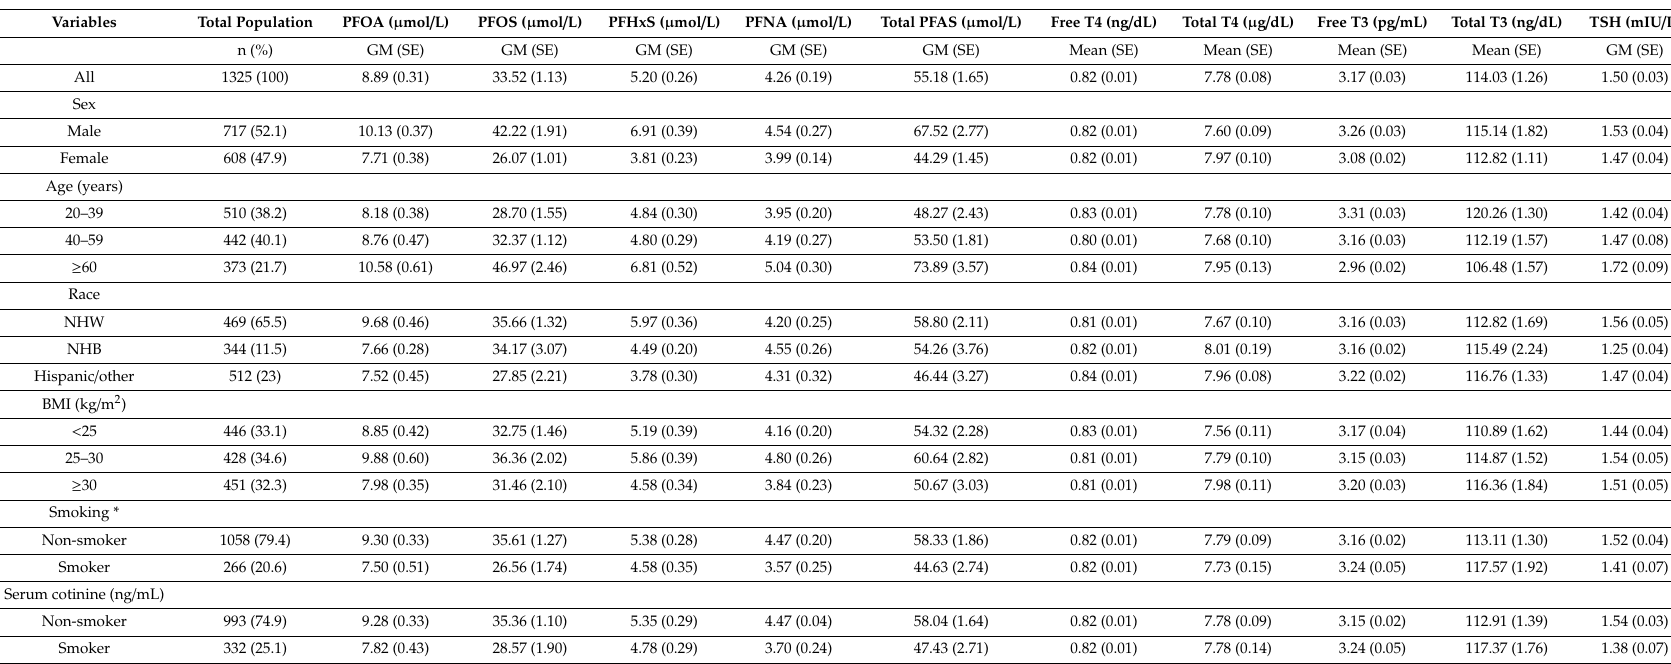
Table 1. Serum perfluoroalkyl acids (PFAS) and thyroid hormone concentrations by participant characteristics in study population ( n = 1325).